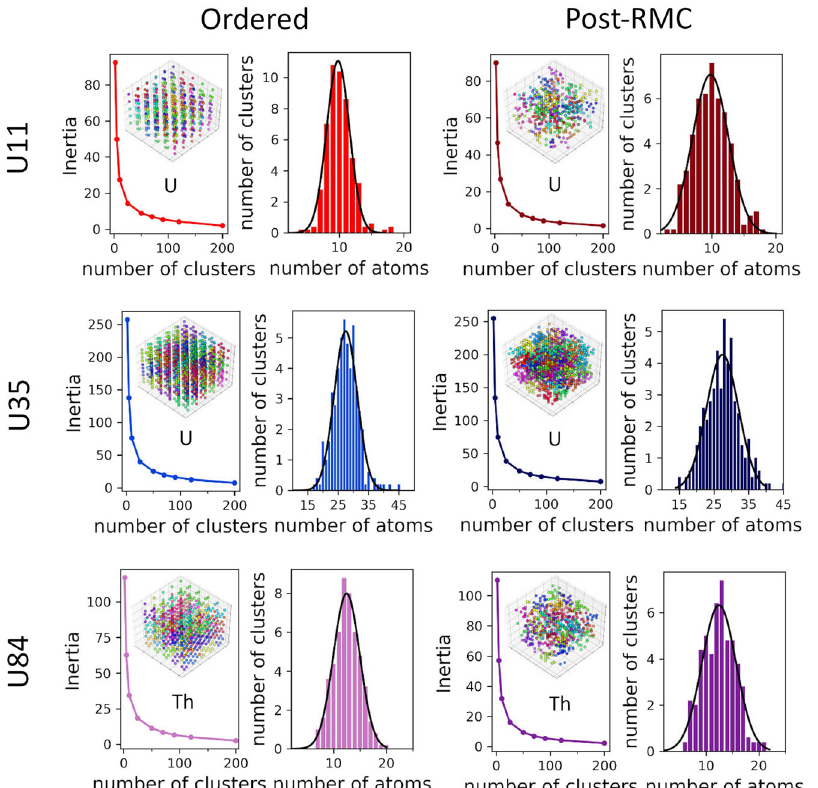
Fig. 5 Inertia-number diagrams and distributions of cluster sizes of U and Th atoms. The insets on the inertia-number diagrams show the positions of the U/Th clusters (denoted with different colors) for the case when 50 clusters were de fi ned ( K =